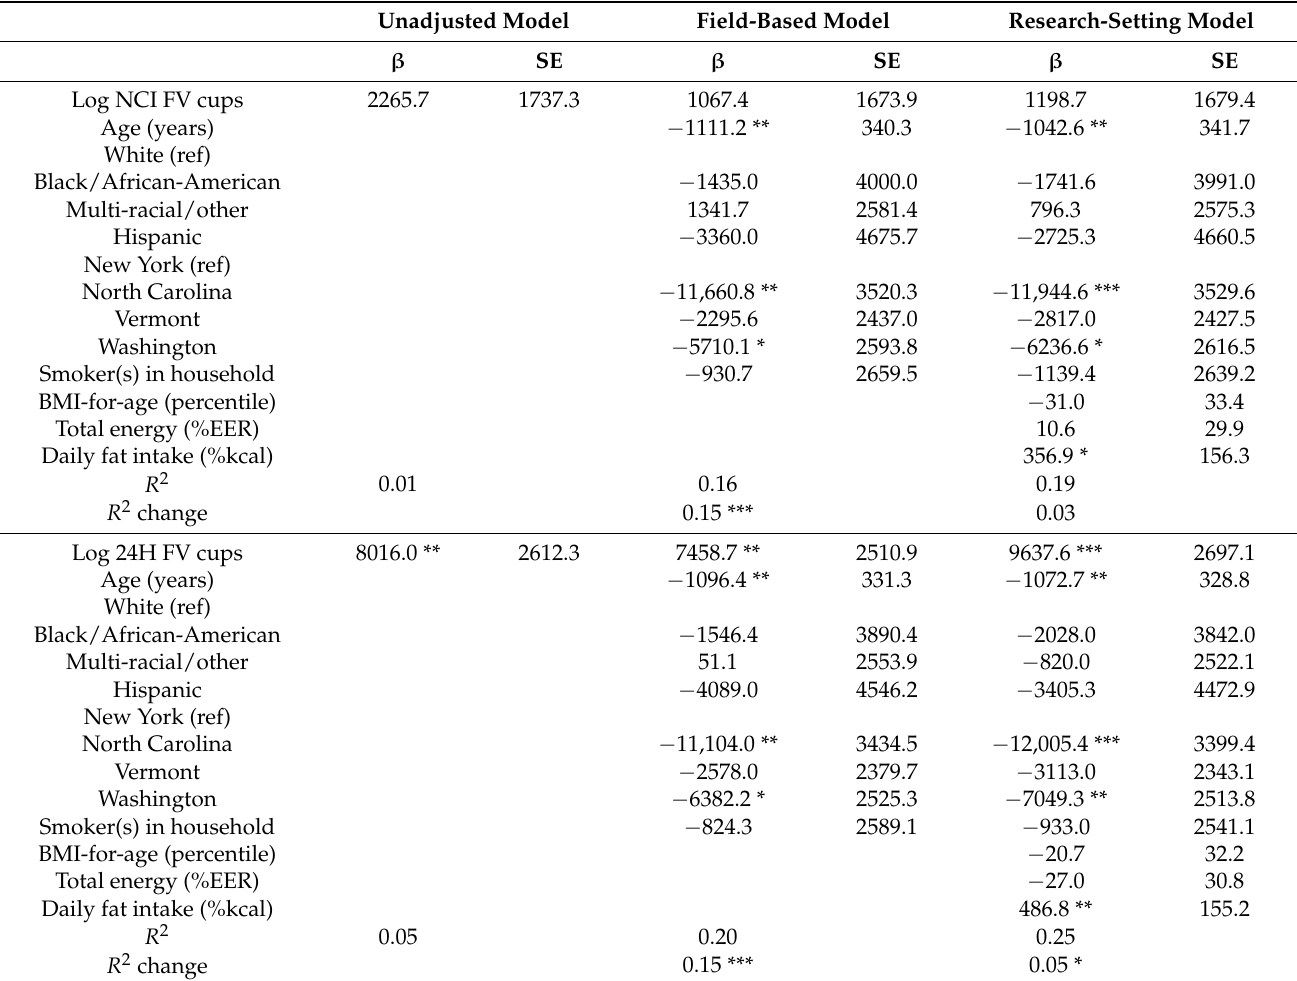
Table 2. Associations between two measures of FV intake and skin carotenoids among children ( n =